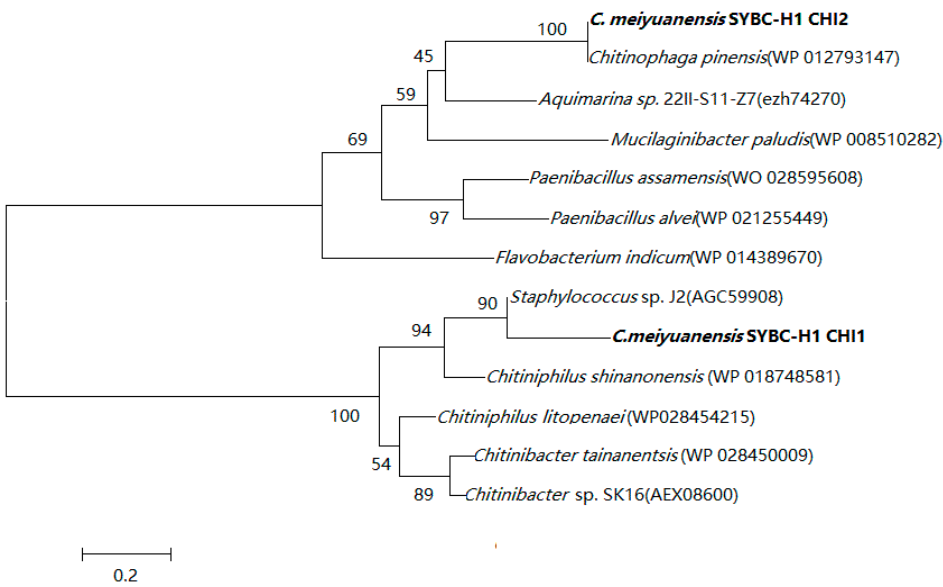
Figure 1. Phylogenetic tree for CHI protein of Chitinolyticbacter meiyuanensis SYBC-H1.